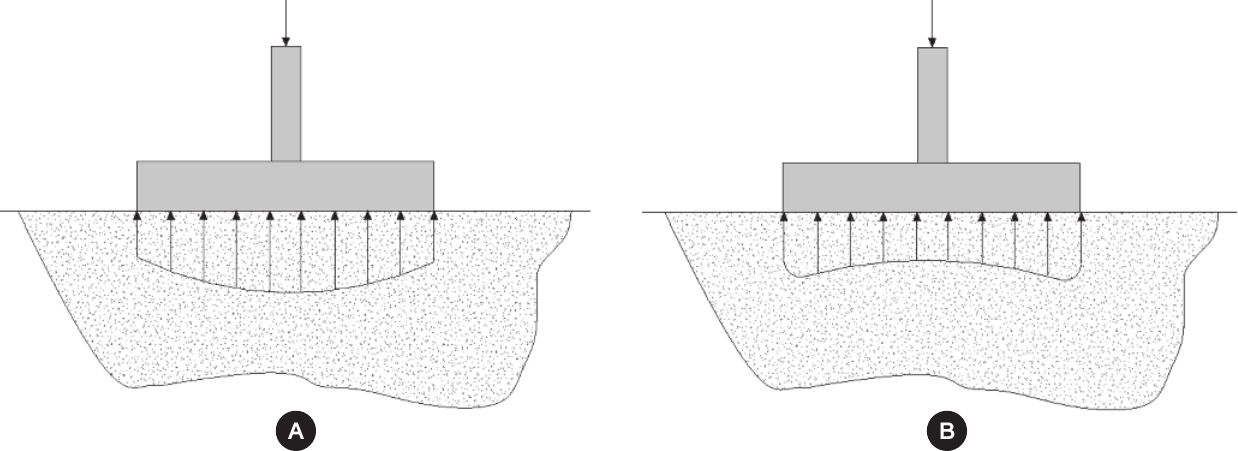
Stress distribution as a function of the soil type. a) sandy soil; b) clayey soil. (MACGREGOR e WIGHT [11])